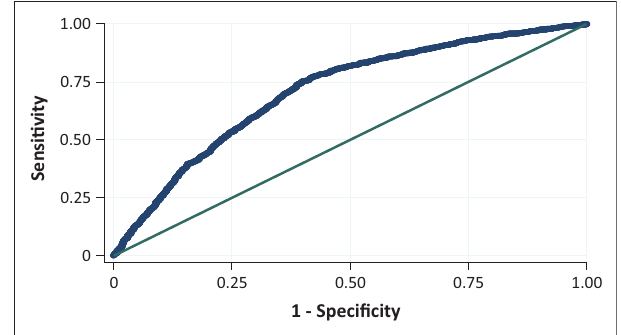
FIG URE 2: Receiver operating characteristic curve - Diversification model.